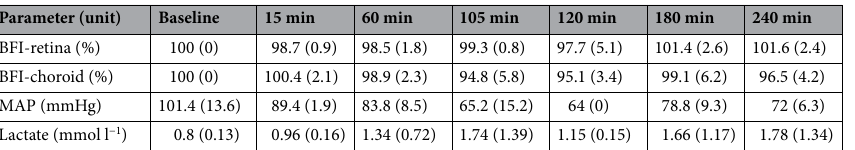
Table 2. Changes of BFI, MAP, and lactate in hemorrhagic shock